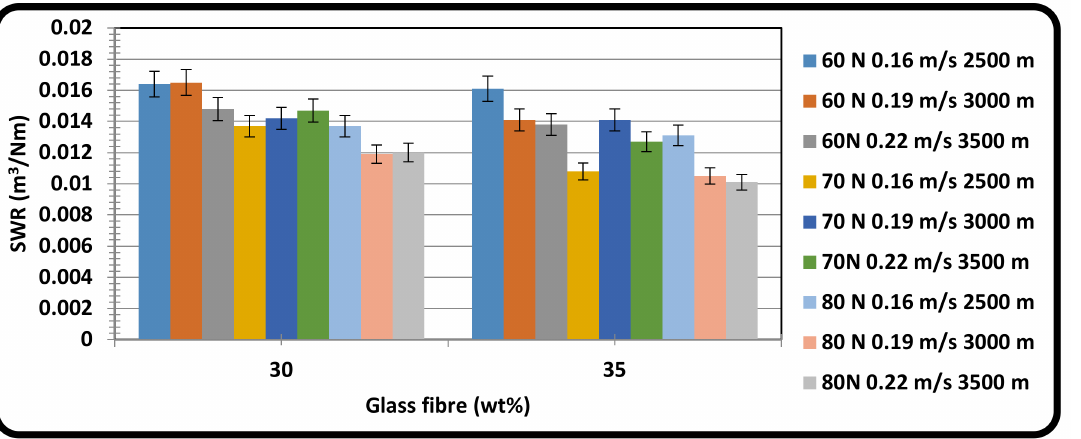
Figure 4. Effect of glass fiber content on SWR at varying loads, sliding velocity, and sliding distance. Also, when the fiber peels out by removal of transfer layer in GFRPA66 30 wt.% after an increase in the load, sliding velocity, and sliding distance, greater contact occurs between the two relatively hard surfaces (EN31 steel and peeled glass fiber) resulting in severe abrasive friction. In case of GFRPA66 35 wt.%, the fiber reinforcement does not peel out as the transfer film is retained even at increased load, sliding velocity and sliding distance, thereby resulting in contact between a hard surface (EN31 steel) and another relatively soft (polymer) material, which corresponds to a soft abrasive friction mechanism, and a lesser